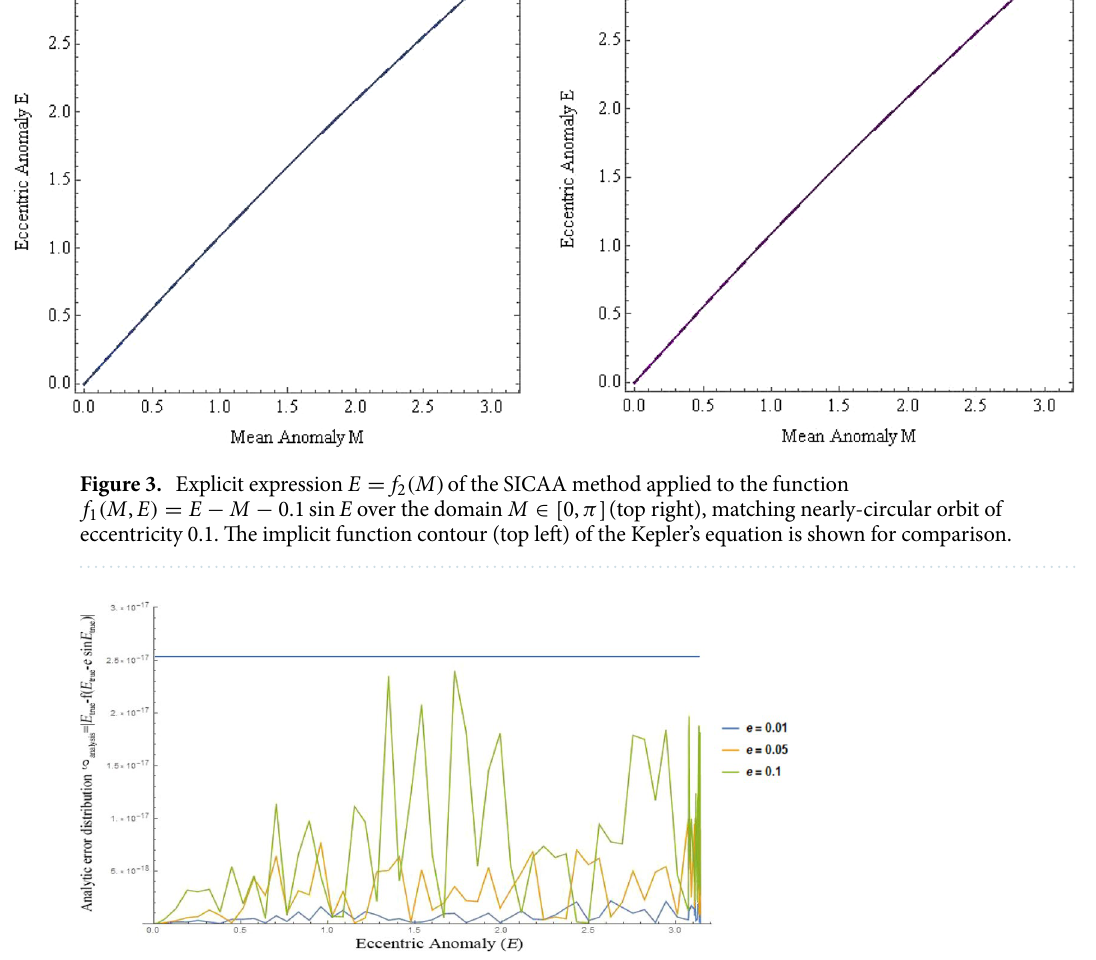
Figure 4. Analytic formula of the error distributions given by δ analysis = over the domain E ∈ [0, π ] , matching nearly-circular orbits of eccentricity 0.01, 0.05,